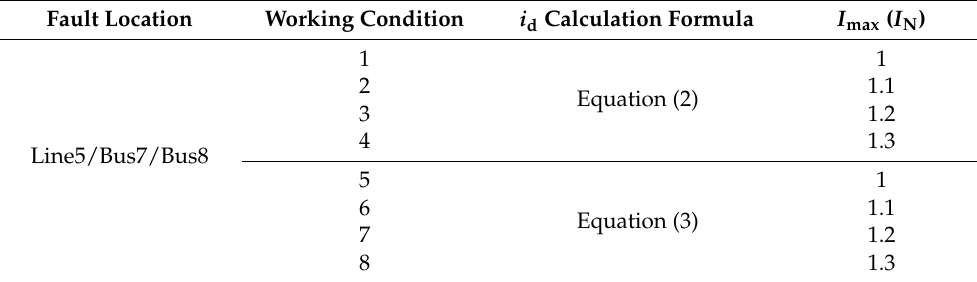
Table 3. Working conditions corresponding to different types of three-phase short-circuit fault.